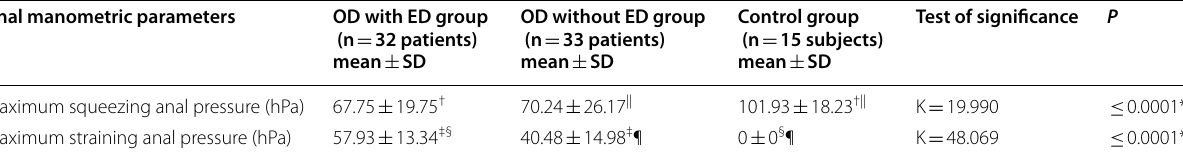
hPa, hectopascal (it is the unit of pressure and it is equal to 100 Pascals); OD, obstructed defecation; ED, erectile dysfunction; n, number of subjects; SD, standard deviation; K, value of Kruskel-Wallis test; Z, value of Mann Whitney test * P is significant at < 0.05 † Statistical significance difference between OD with ED group versus control group (Z ‡ Statistical significance difference between OD with ED group versus OD without ED group (Z § Statistical significance difference between OD with ED group versus control group (Z || Statistical significance difference between OD without ED group versus control group (Z ¶ Statistical significance difference between OD without ED group versus control group (Z Table 3 Pelvic floor electrophysiological parameters of the two patient groups and control group